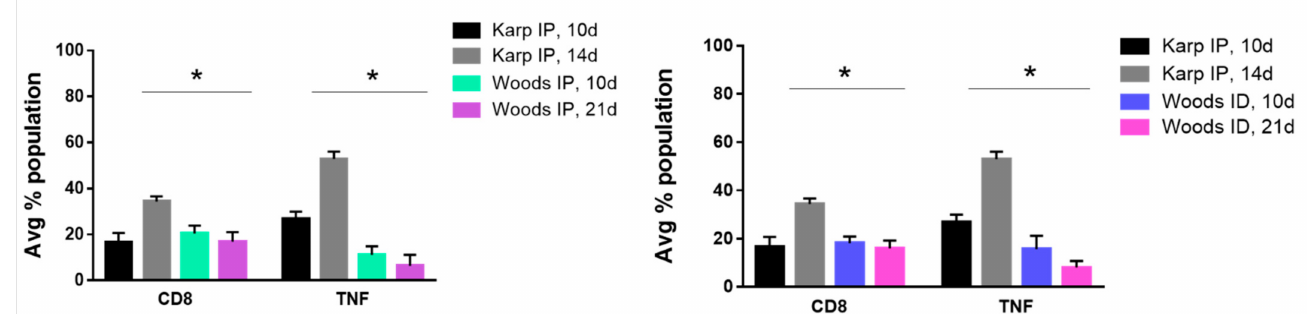
Figure 9. CD8 lethal cytokine signature. Significant differences in CD8 populations and TNF cytokine populations were observed in interstrain comparisons between the lethal and nonlethal models. In both interstrain comparisons, significant increases in CD8+ cells and TNF producing cells were observed in the lethal model at 14 dpi when compared to nonlethal models 21 dpi. Significant differences between average cytokine populations in the lethal and nonlethal models are indicated by asterisks (*, p <